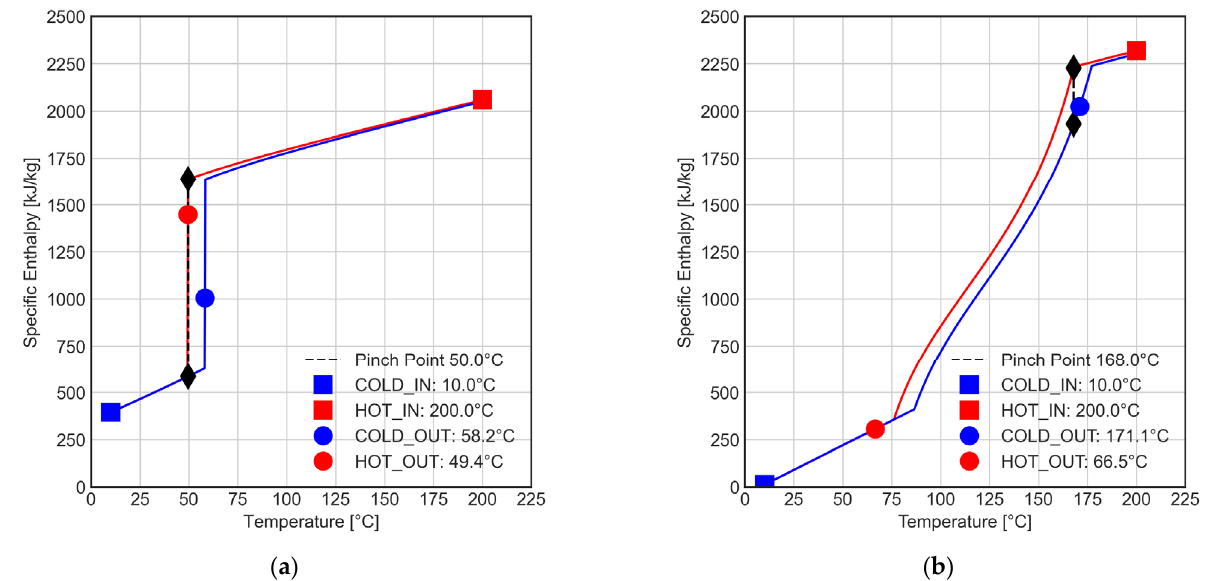
Figure 5. Calculation of the theoretical maximum possible heat transfer with regeneration for pure ammonia ( a ) and an ammonia/water mixture 65/35 wt.% ( b ) at. P L = 20 bar ∆ P = 5 bar. Blue line = fluid receiving heat, red line = fluid delivering heat.